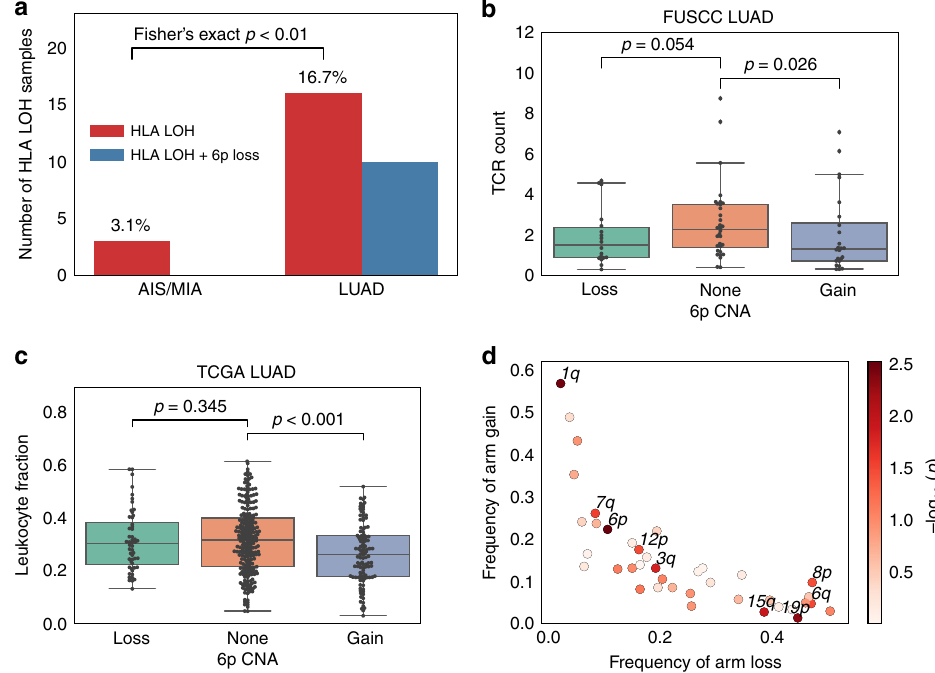
Fig. 3 Tumor immune environment in association with arm-level CNA. a Frequency of loss of HLA heterozygosity and the co-occurrence of HLA LOH with 6p loss. Signi fi cantly more HLA LOH events are found in the LUAD group compared to the AIS/MIA group. b Comparison of inferred T cell in fi ltration in FUSCC LUAD samples and c leukocyte in fi ltration 15 in TCGA LUAD samples with 6p CNA loss, gain, or no change. P values are calculated from Mann – Whitney U test. Signi fi cantly decreased level of T cell or leukocyte in fi ltrations are found in 6p gain samples compared to 6p neutral samples. In the box plots, the upper and lower hinges represent the fi rst and third quartile, the whiskers span the fi rst and third quartile, and center lines represent the median. d Correlation of arm-level CNA with leukocyte in fi ltration for the TCGA LUAD samples. P values are calculated from multivariate linear regression, while each arm is assigned 1 if gained, − 1 if lost and 0 if unchanged, and adding the aneuploidy score 18 and TMB as covariates. Source data are provided as a source data fi